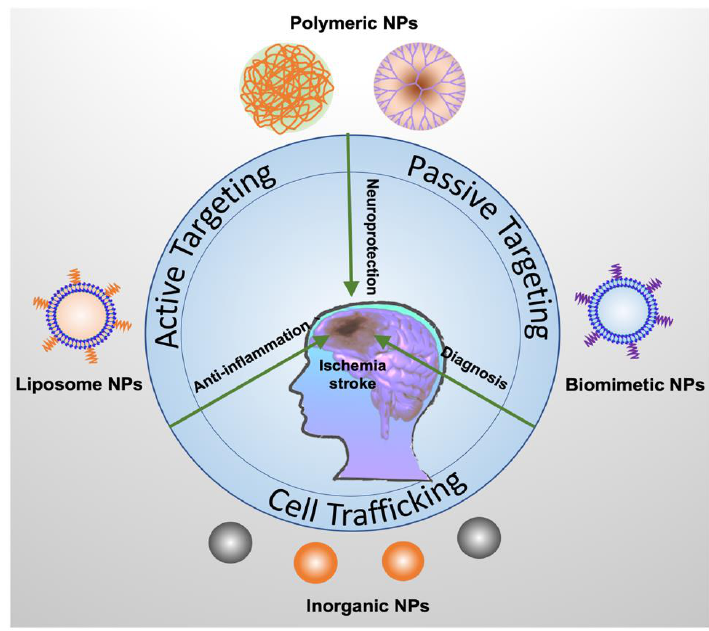
Figure 3. Nanoparticle-based delivery platforms for delivery of neuroprotectants, anti-inflammation reagents, and imaging probes for ischemic stroke therapy and diagnostics. Polymeric NPs include PLGA (poly(lactic-co-glycolic acid) NPs, chitosan NPs, and PAMAN dendrimer. Liposomes are made of a lipid bilayer and are loaded with therapeutics agents. Inorganic NPs include metallic NPs (such as platinum), ceria NPs, and Fe 2 O 3 NPs. Biomimetic NPs are new drug delivery platforms generated from cell membrane vesicles. Each type of NPs has been discussed in the